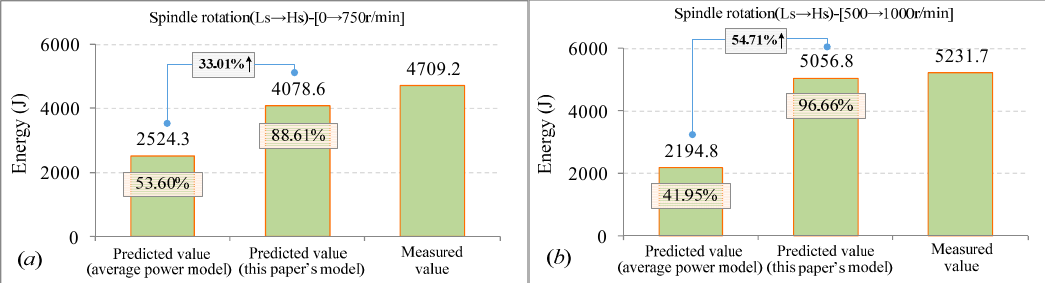
Figure 16. Comparison of predicted values and measured values for ( a ) spindle rotation (Ls → Hs)-[0 → 750 r/min] and ( b ) spindle rotation (Ls → Hs)-[500 → 1000 r/min].